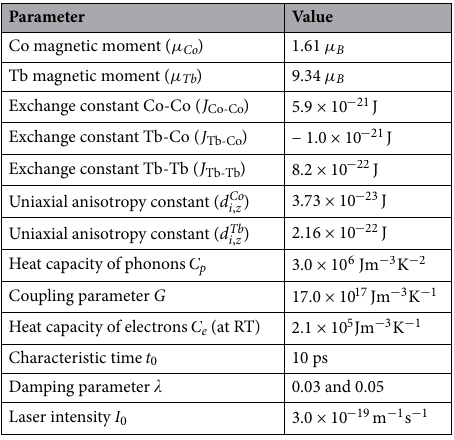
Table 1. List of parameters used for the numerically calculated static and dynamic properties of Tb n Co m